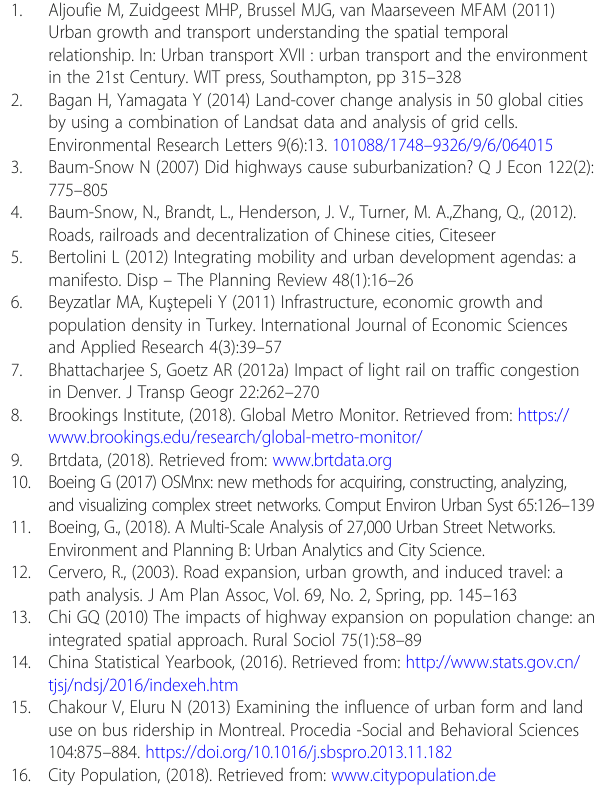
Table 5 Scaling of multi-variant graphs Figs 2-4 Urban Train IA [km railway per 10 inh]: